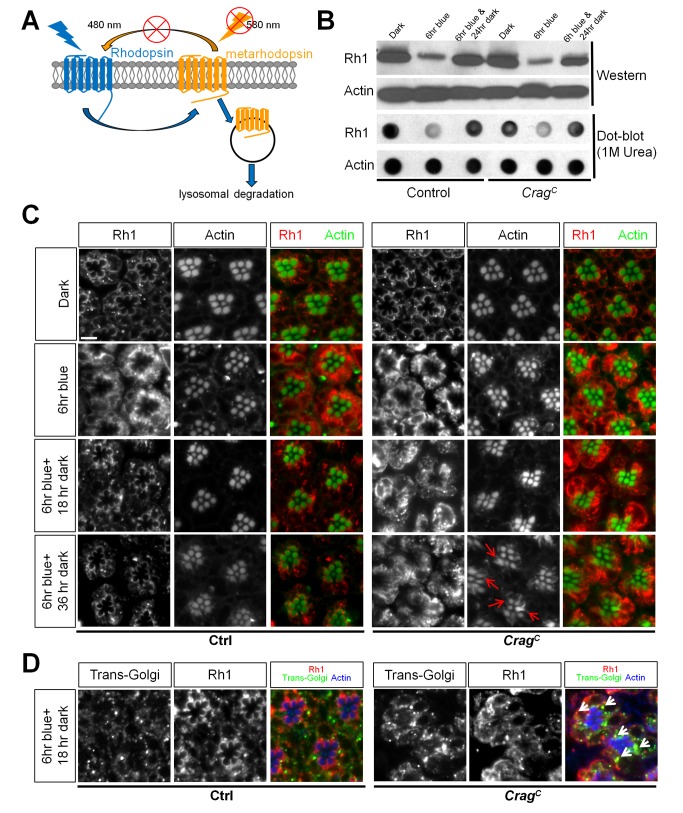
Crag is required for Rh1 transport to the rhabdomeres upon light stimulation.(A) In adult flies, blue light triggers the conformational change of Rh to metaRh, whereas orange light is required for converting metaRh to Rh. In the presence of blue light and absence of orange light, metaRh is accumulated in the rhabdomere, which in turn triggers massive endocytosis and degradation of Rh. (B) Fly heads with control or CragC mutant clones in the eyes were collected from flies that were kept in the dark or in blue light for 6 h with or without 24 h of recovery. Western blots and dot blots were performed to detect total Rh1 and Actin (loading control) levels. Note that in both genotypes, the Rh1 level significantly decreased after 6 h of blue light treatment and was restored after 24 h of recovery in the dark. (C) Whole mount staining of Rh1 in photoreceptors kept in the dark, exposed to 6 h of blue light, or exposed to 6 h blue light with 18 or 36 h of recovery in the dark. 6 h of blue light treatment triggers massive endocytosis of Rh1 in both control and Crag mutant photoreceptors. Note the strong Rh1 staining in the cytosol. After 18 h of recovery, a crescent shaped pattern of Rh1 is reformed in controls but not in Crag mutant photoreceptors. Rh1 accumulation is persistent in Crag mutant cells after 36 h of recovery. Note that breakdown of rhabdomeres (indicated by red arrows) is observed in flies kept for 36 h in the dark but not in flies kept for 18 h in the dark after blue light exposure. Scale bar, 5 µM. (D) Immunostaining of the trans-Golgi compartment (Peanut agglutinin) and Rh1 in flies after 6 h of blue light exposure and 18 h of dark recovery. Note the enlargement of the trans-Golgi compartment and the colocalization between Rh1 and the trans-Golgi compartment (indicated by white arrowheads) in Crag mutant cells.